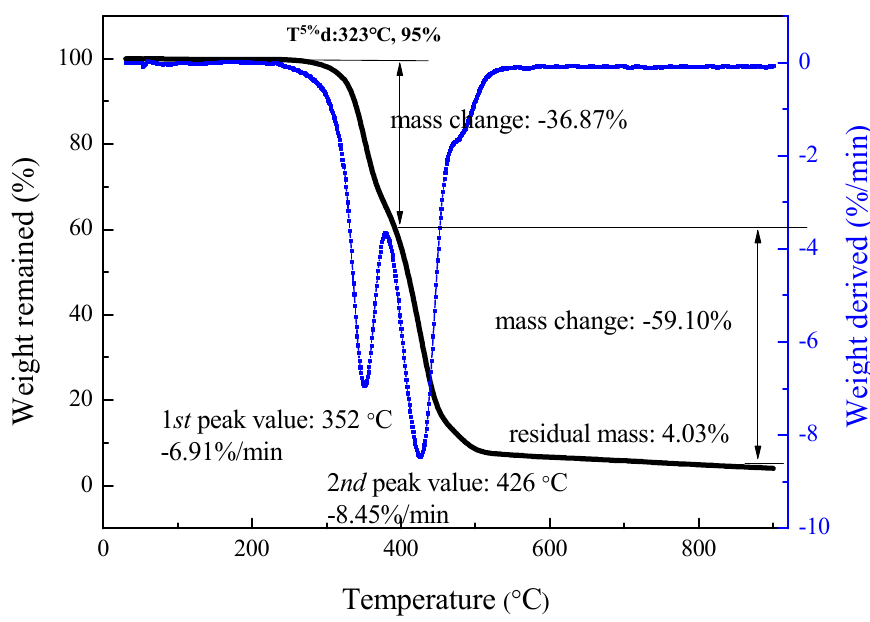
Figure 7. Thermal gravimetric analysis/differential thermal gravimetric analysis curves of BTPU sample.